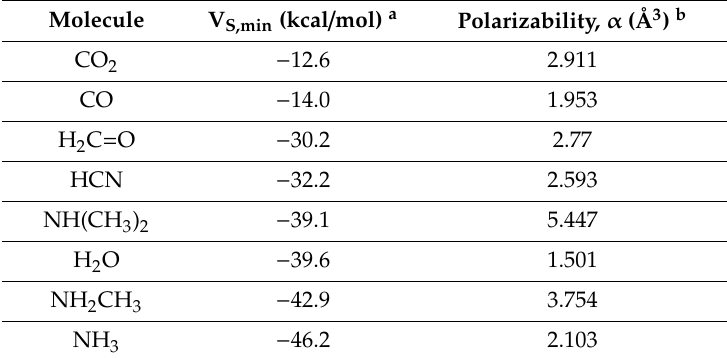
Table 3. Computed V S,min and experimental polarizabilities of negative